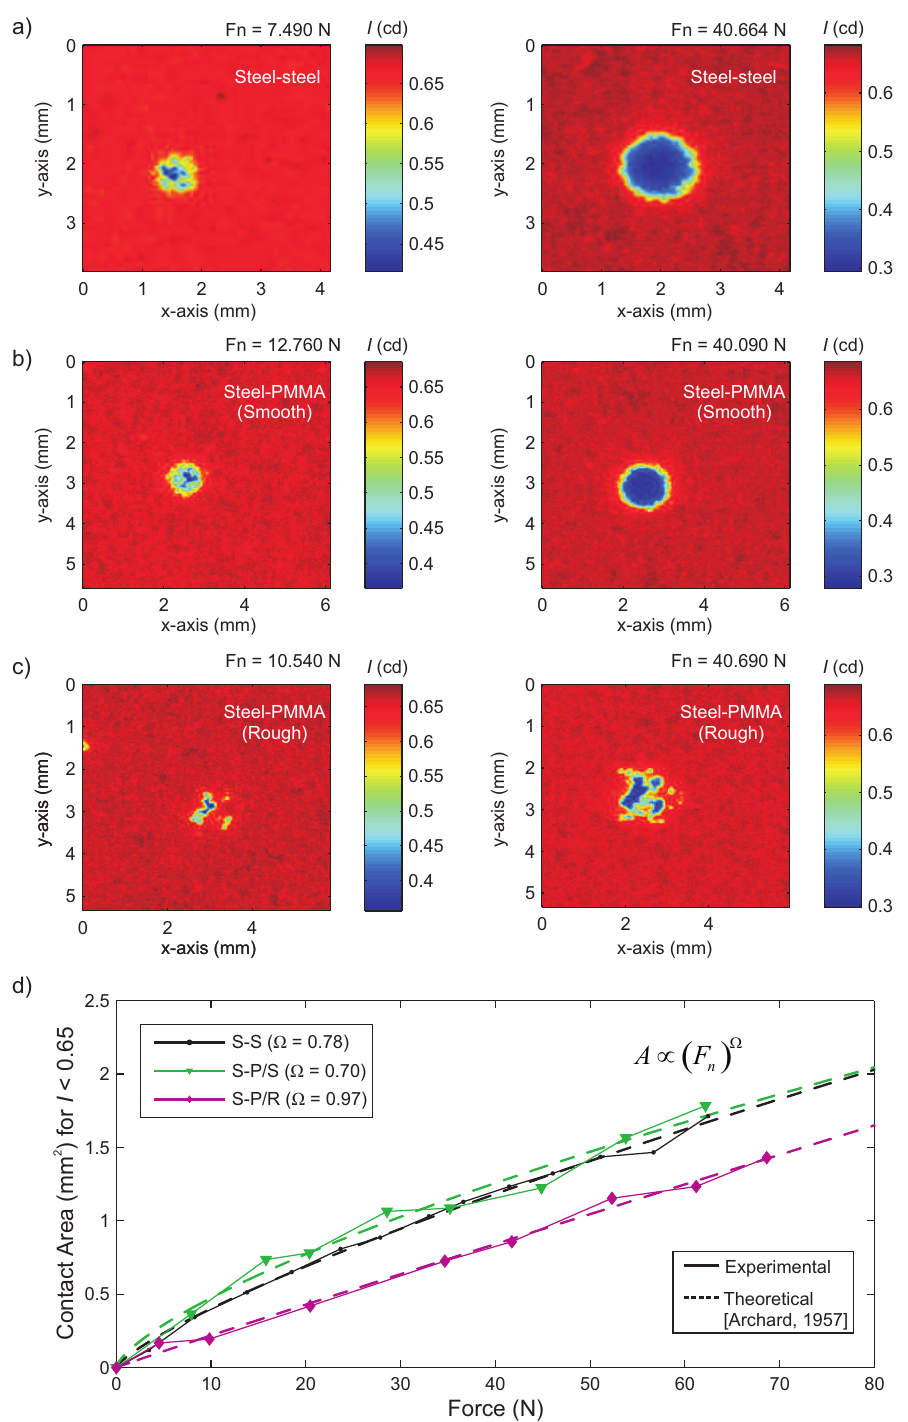
Figure 5. Light intensity (cd) obtained from the pressure-sensitive film for variable substrates pressed against with the same steel indenter. For a lower ( ∼ 10 N) and higher ( ∼ 40 N) applied normal force, we see the variations due to the: ( a ) steel substrate (S-S); ( b ) the smooth PMMA substrate (S-P/S); and ( c ) the rough PMMA substrate (S-P/R); ( d ) the comparison of the area, defined by pixels below the intensity threshold I = 0.65 cd, versus the applied normal force F . The results are compared to the theoretical estimates made by n Archard